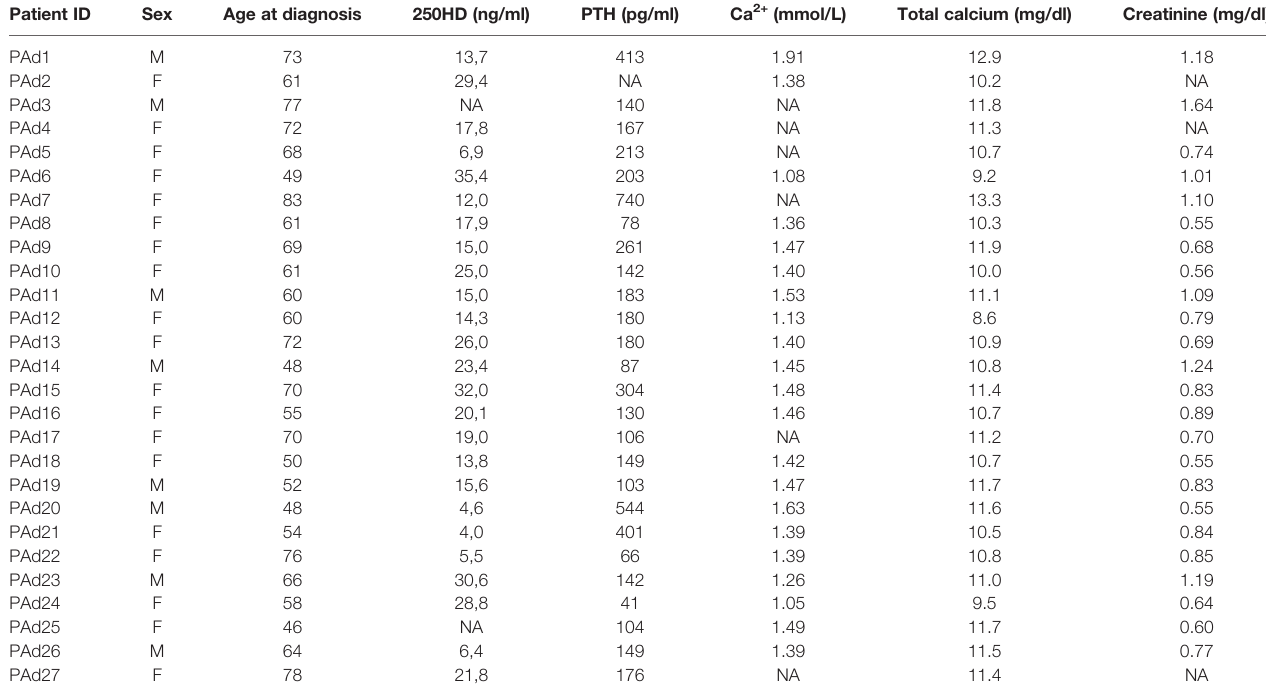
TABLE 1 | Clinical and biochemical data of parathyroid adenomas. Patient